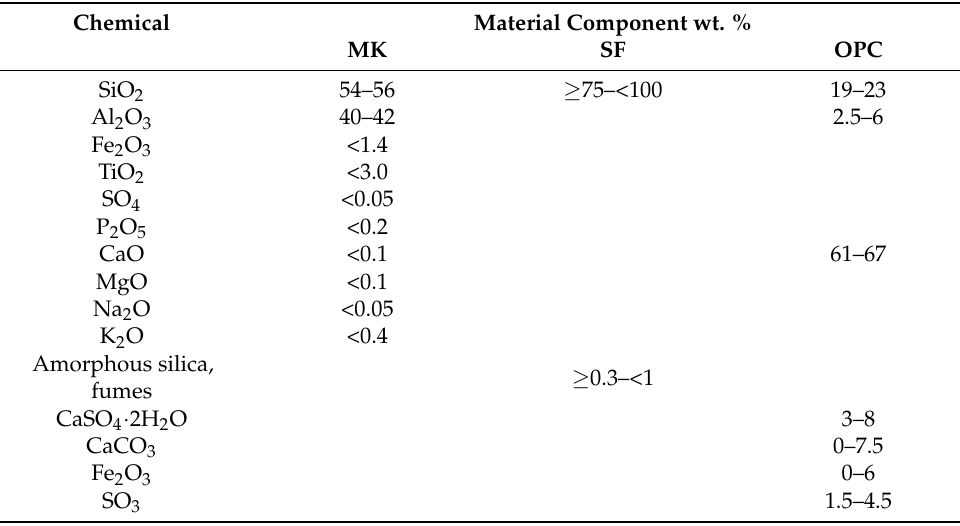
Figure 1. Fibre preparation methodology . Table 1. Composition of materials adopted from [15] .